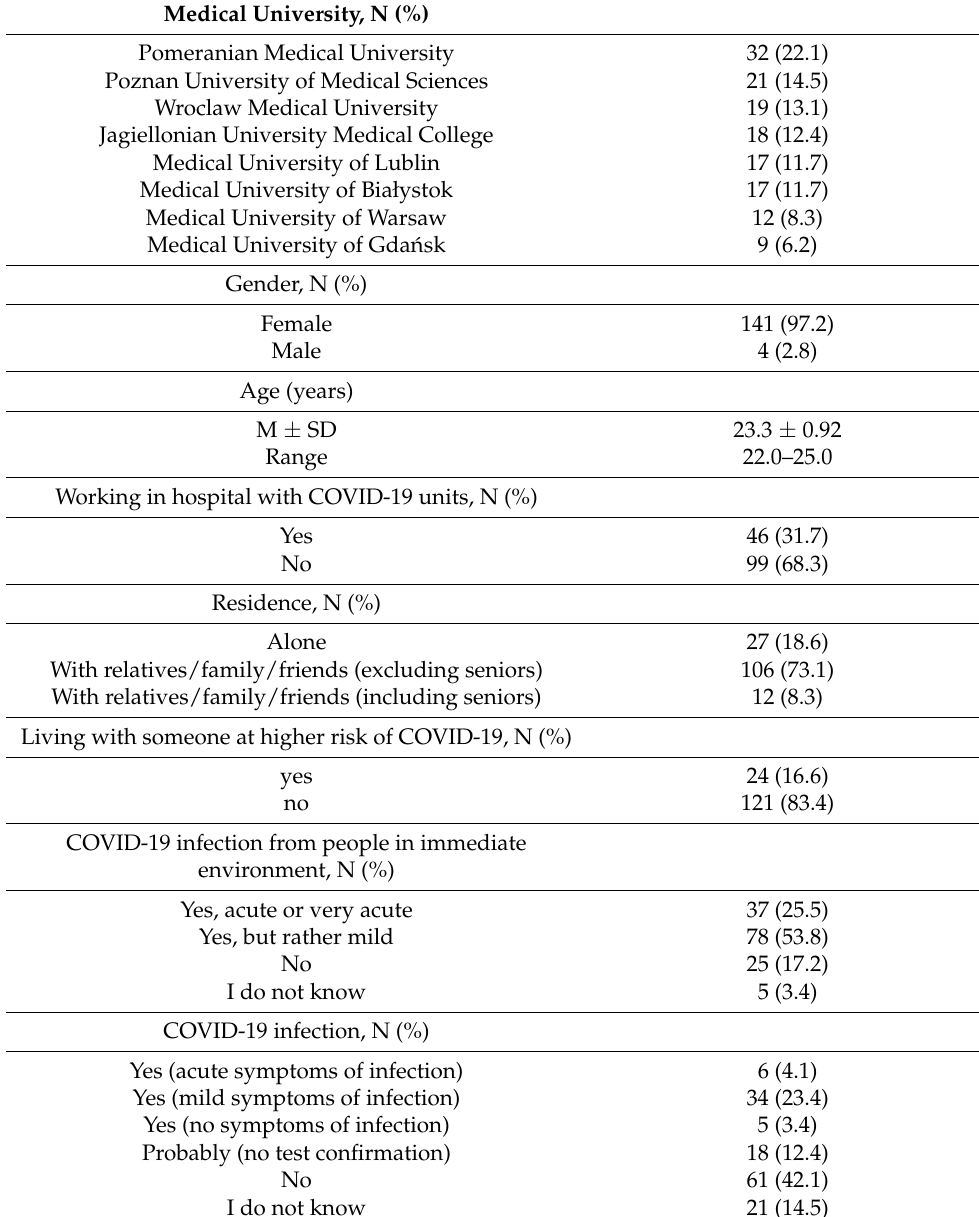
Table 1. Characteristics of the study group (N =